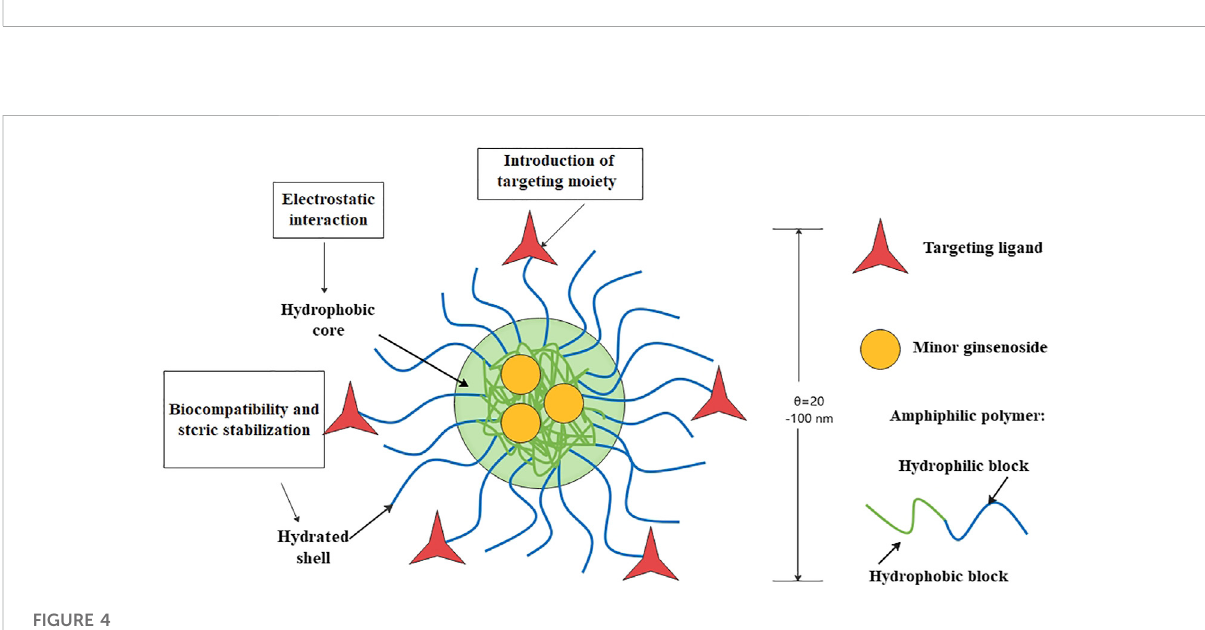
FIGURE 4 Structure and functions of